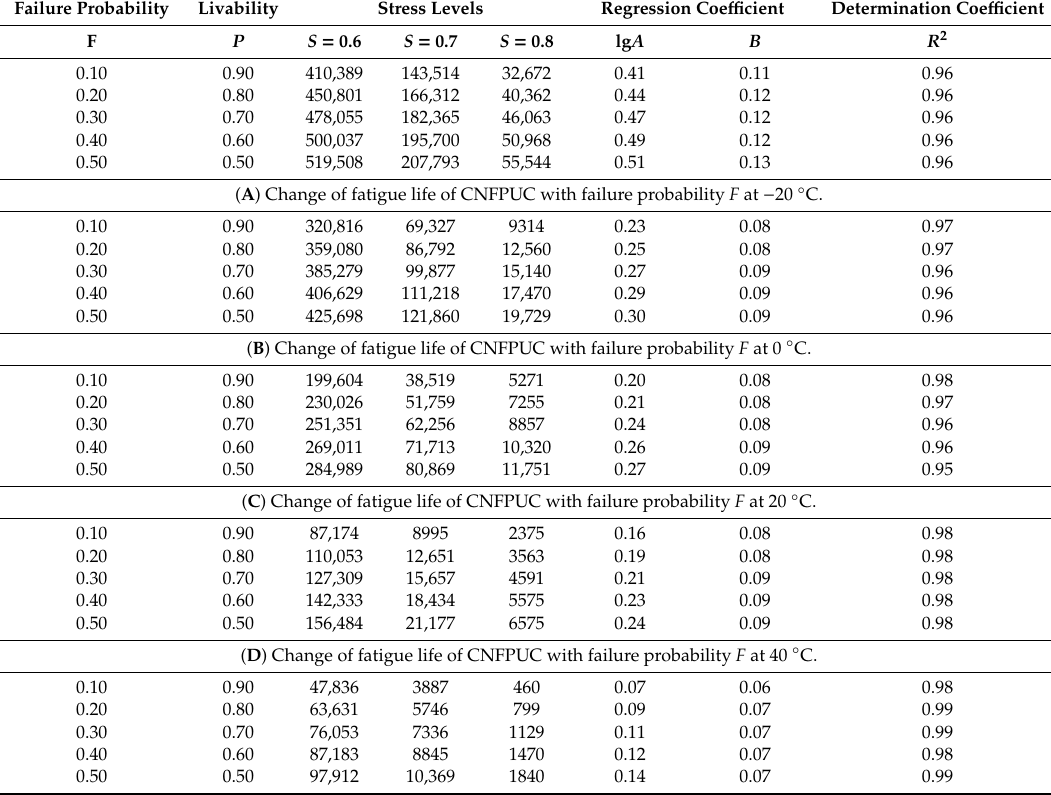
Table 11. The change of the fatigue life with the failure probability F ( A – D ). Change of fatigue life of CNFPUC with failure probability F at − 40 ◦